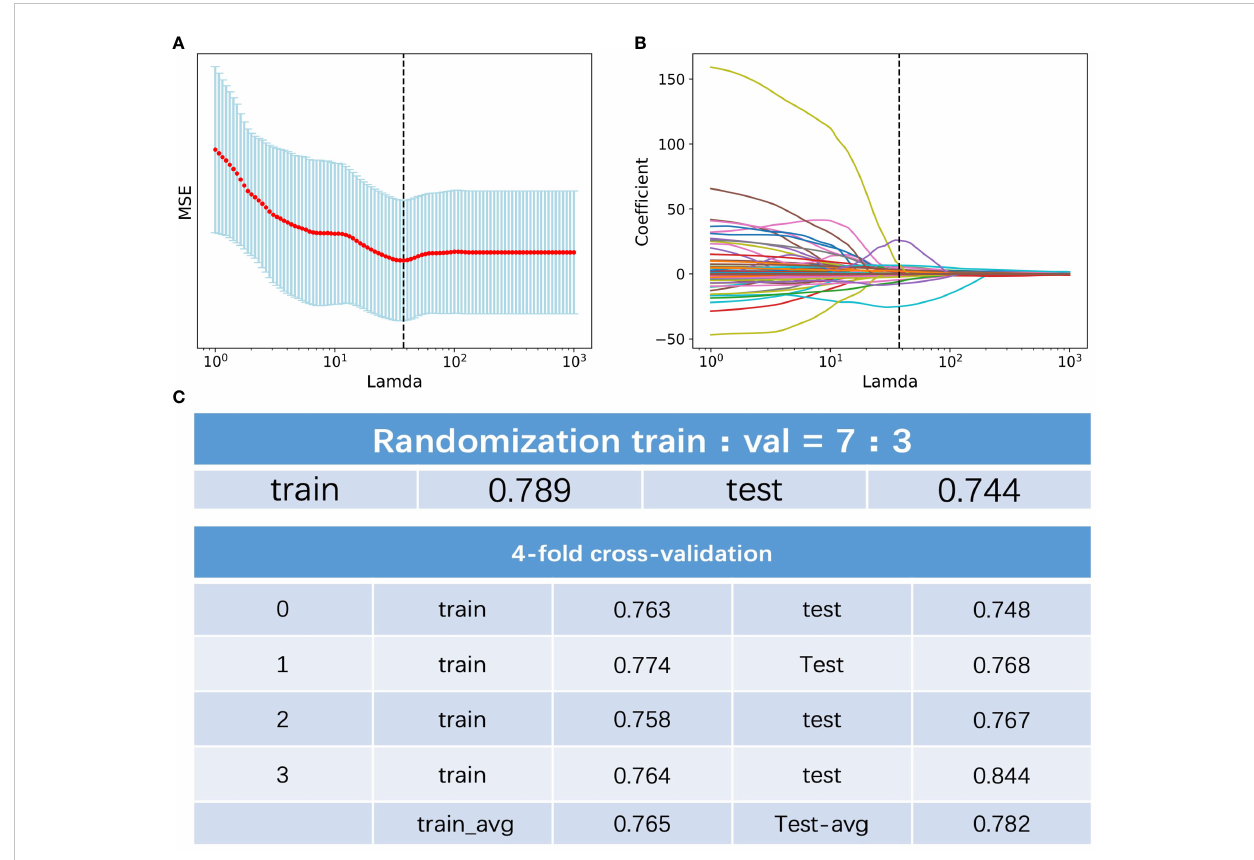
FIGURE 1 Feature selection of the radiomics data. (A) Selection of the tuning parameter lamda in the LASSO model. (B) LASSO coef fi cient pro fi les of the selected texture features. (C) C-index of the of the 11 features cox regression and validation by the randomization of training and testing